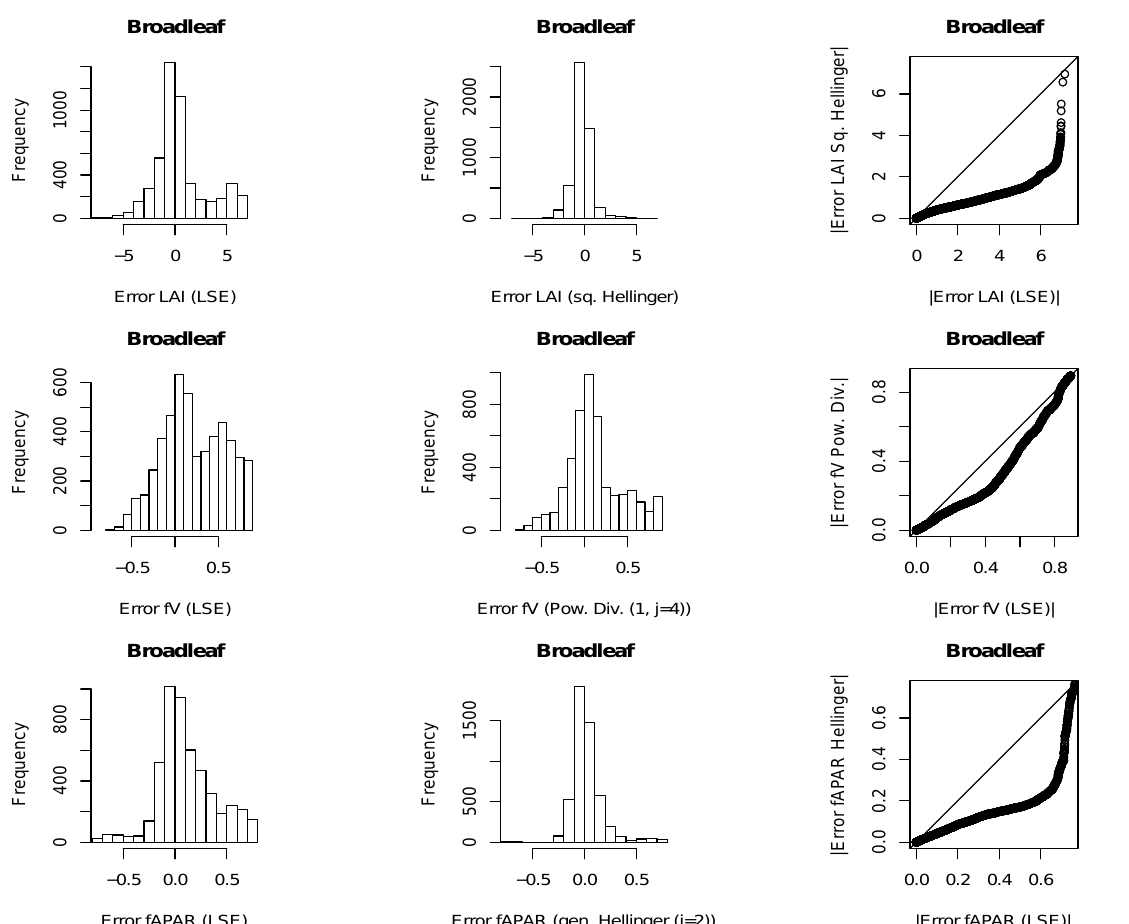
Figure 1. Comparison of residual errors resulting from the application of two different distance measures used to estimate biophysical parameters for broad leaf canopies with a look-up table (LUT). Biophysical parameters, including leaf area index, LAI , fraction of photosynthetically active radiation absorbed by the canopy, f , and vegetation cover APAR fraction, f , are estimated from simulated ground reflectance values. The rows from top V to bottom show the comparison of residual errors in estimating LAI with the least squares estimate (LSE) and Hellinger Equation (10) (top row), of residual errors in f with LSE and V the power divergence Equation (12) with power 1 and j = 4 (centre row) and of residual errors in f with LSE and the Hellinger equation (bottom row). The columns from APAR left to right show frequency distributions of residual errors using LSE as a cost function (left column) and the residual errors using either a Hellinger Equation (10) for LAI and f or a power divergence Equation (12) with power 1 and j = 4 for f (centre column). APAR V The right column shows the quantile–quantile plots comparing the frequency distributions of the left and centre columns expressed as absolute errors. The errors in biophysical parameters associated with the alternative cost functions are smaller and better behaved (more symmetrical and smaller